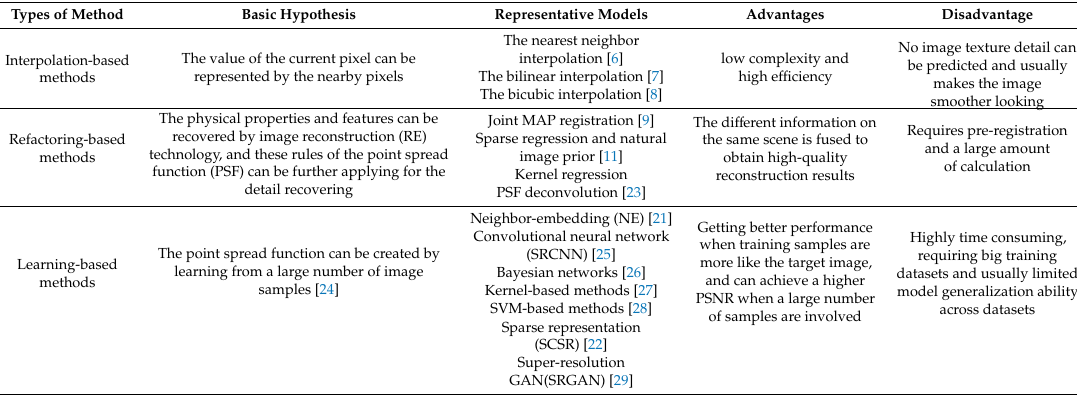
Table 1. The comparison of super-resolution